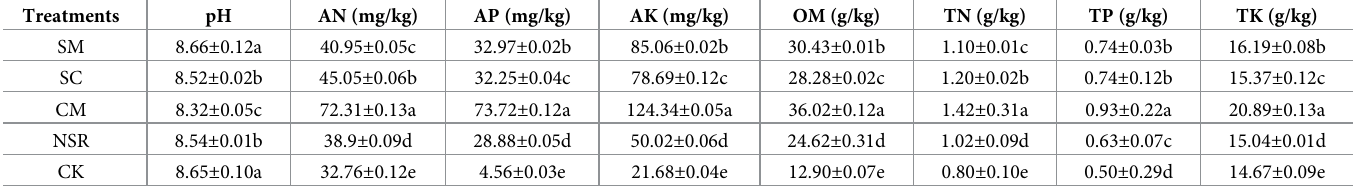
Table 2. Soil pH and nutrient contents in a utilization and fertilization experiment.